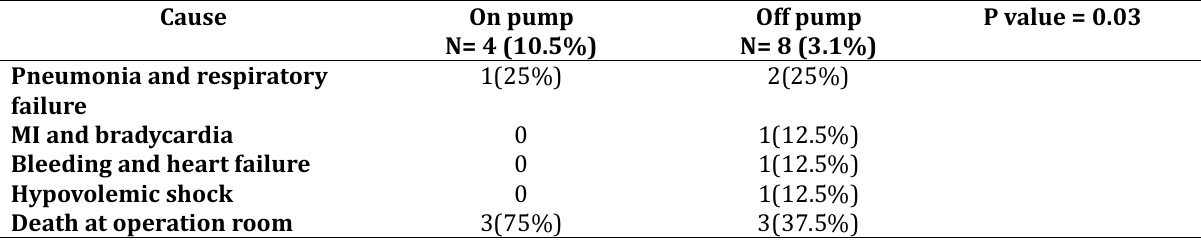
Table 5 : Mortality rate of patients